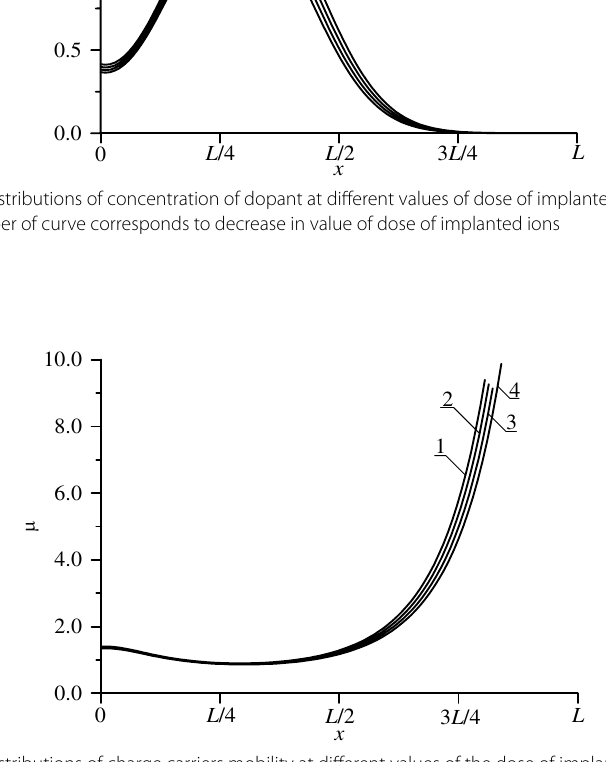
Fig. 3 Typical distributions of charge carriers mobility at different values of the dose of implanted ions. Increasing number of curve corresponds to increasing value of dose of implanted